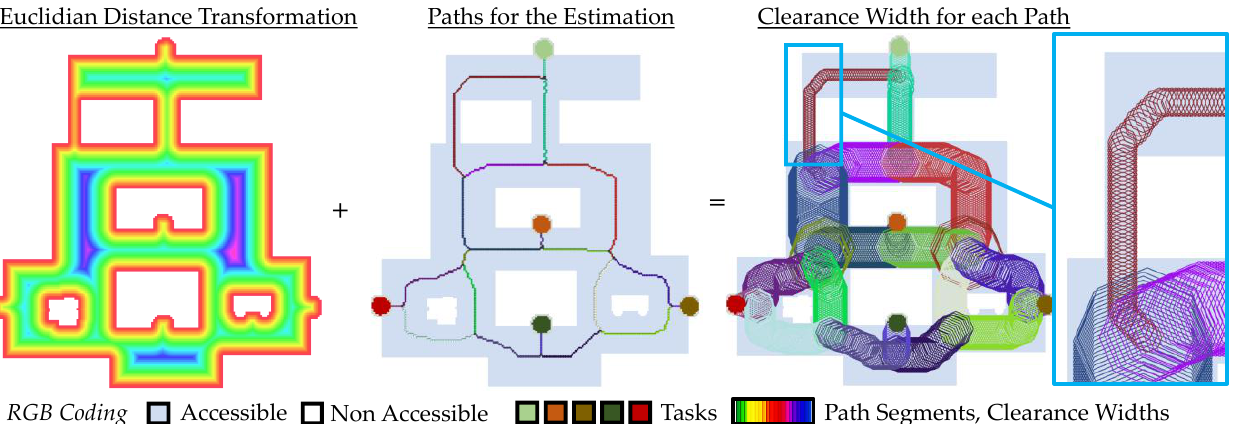
Figure 13. Minimum clearance width estimation: Euclidean distance transformation, segmented paths, passage width of each path.